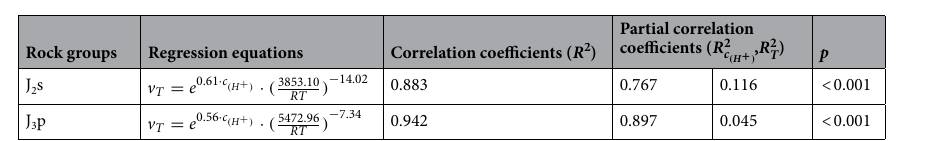
Table 4. Quantitative model of cation release rates for the two groups of rock.